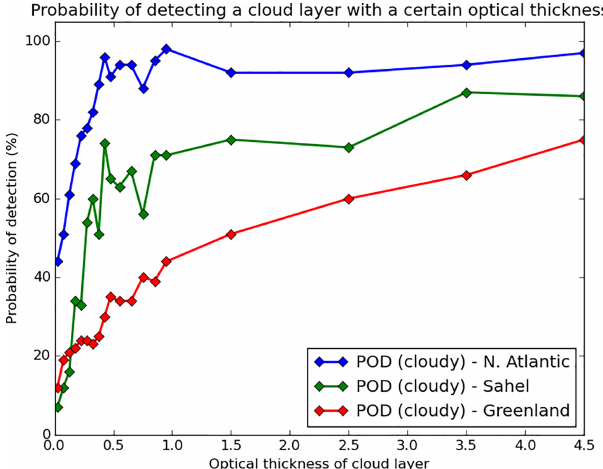
Figure 13. Same as Fig. 6 but for the individual grid points marked in Fig.